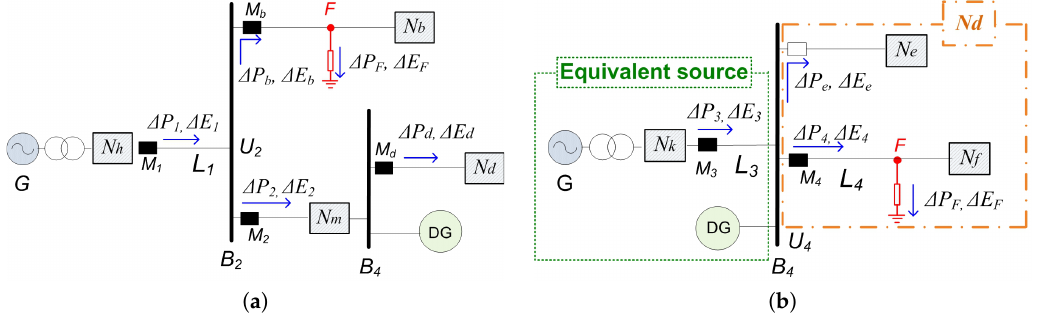
Figure 9. Simplified topologies in ( a ) Scenario 4 and ( b ) Scenario